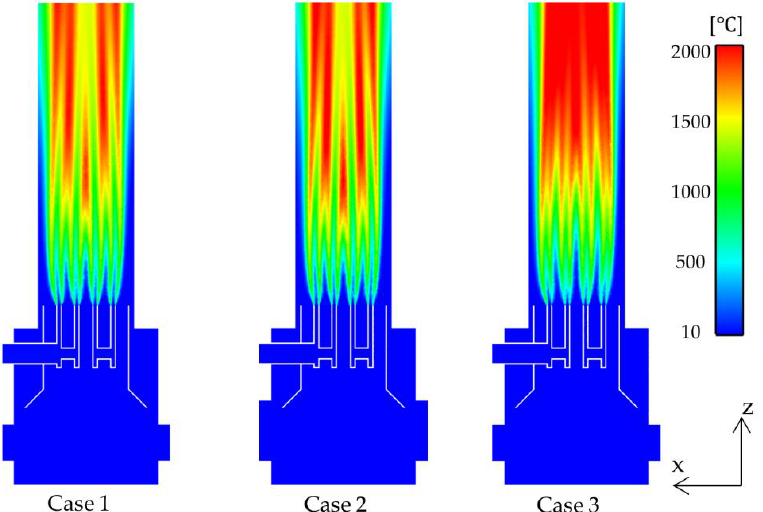
Figure 9. Comparison of temperature contours in the axial plane under different airflow condi- tions.